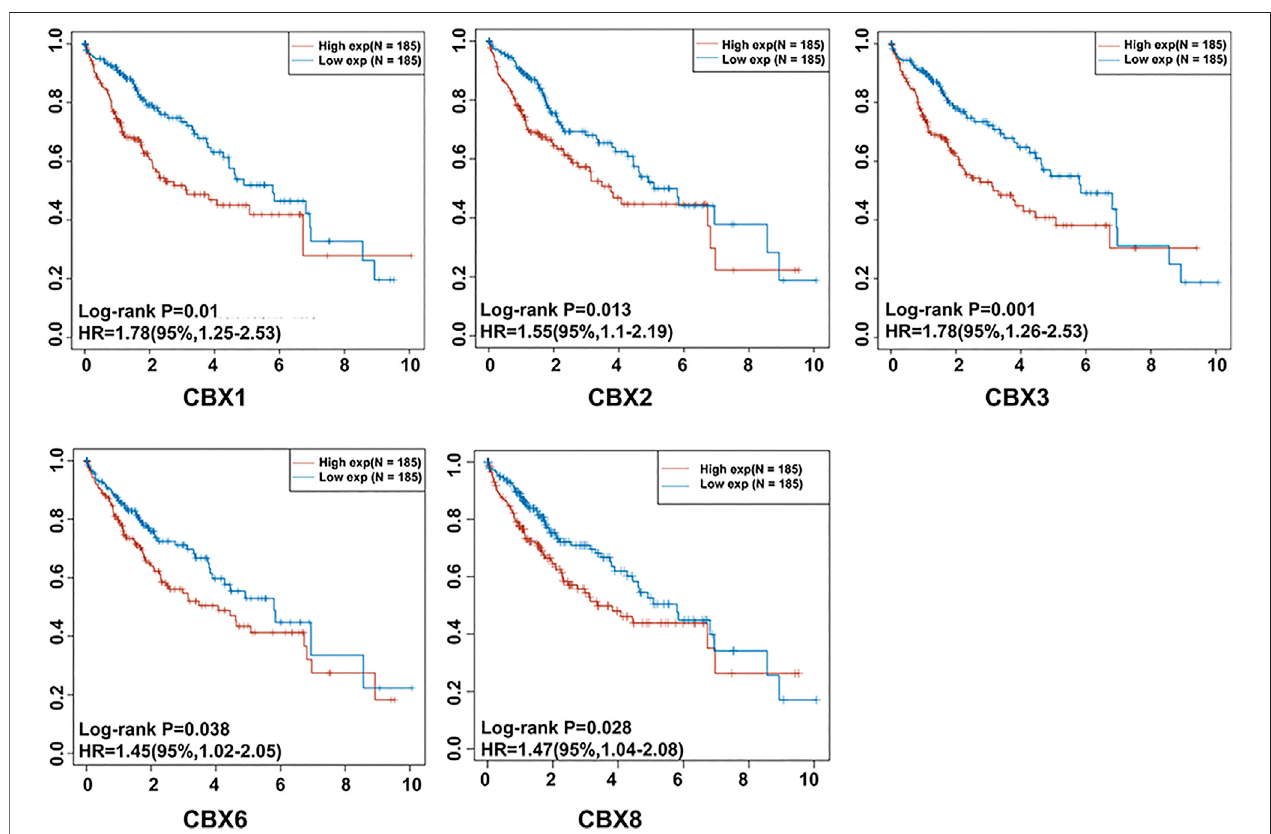
FIGURE 2 | The prognostic signi fi cance of unique CBX family members ’ mRNA expression in HCC. Patients with HCC who had elevated CBX1/2/3/6/8 transcriptional levels had a substantially shorter OS ( p <